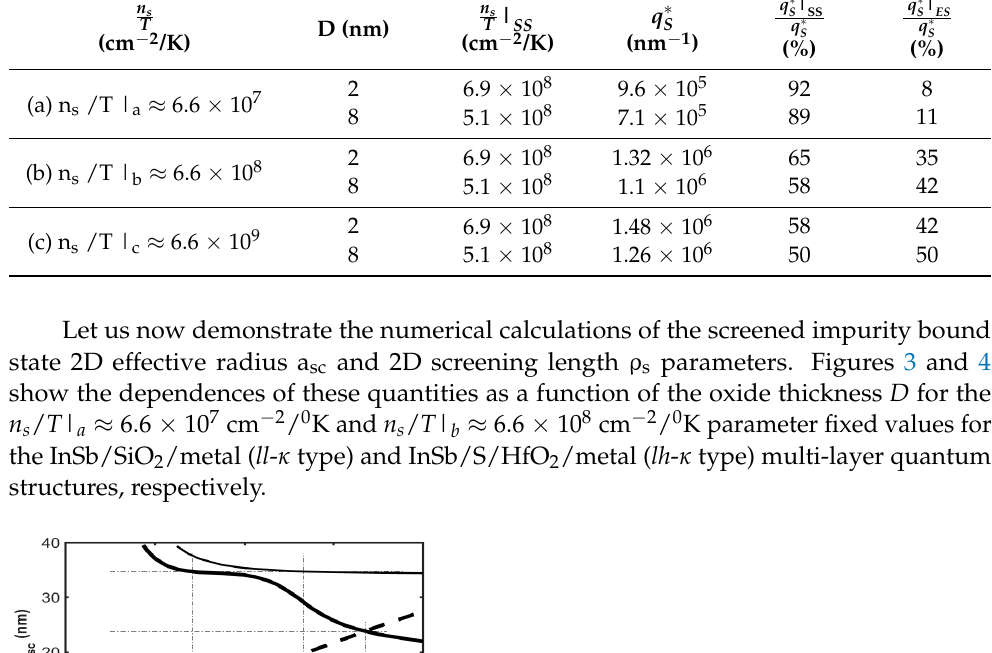
(cid:12) (cid:12) , q ∗ and q ∗ parameter values with the (cid:12) (cid:12) S S S SS ES